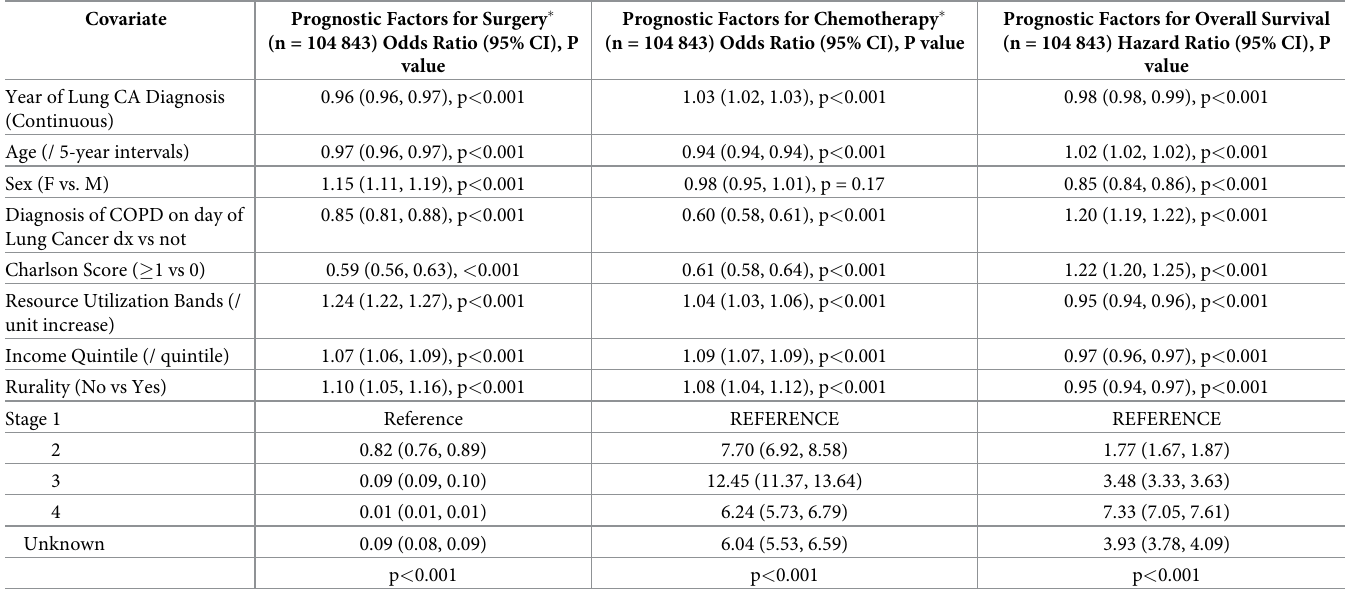
Table 4. Multivariable analysis of management and